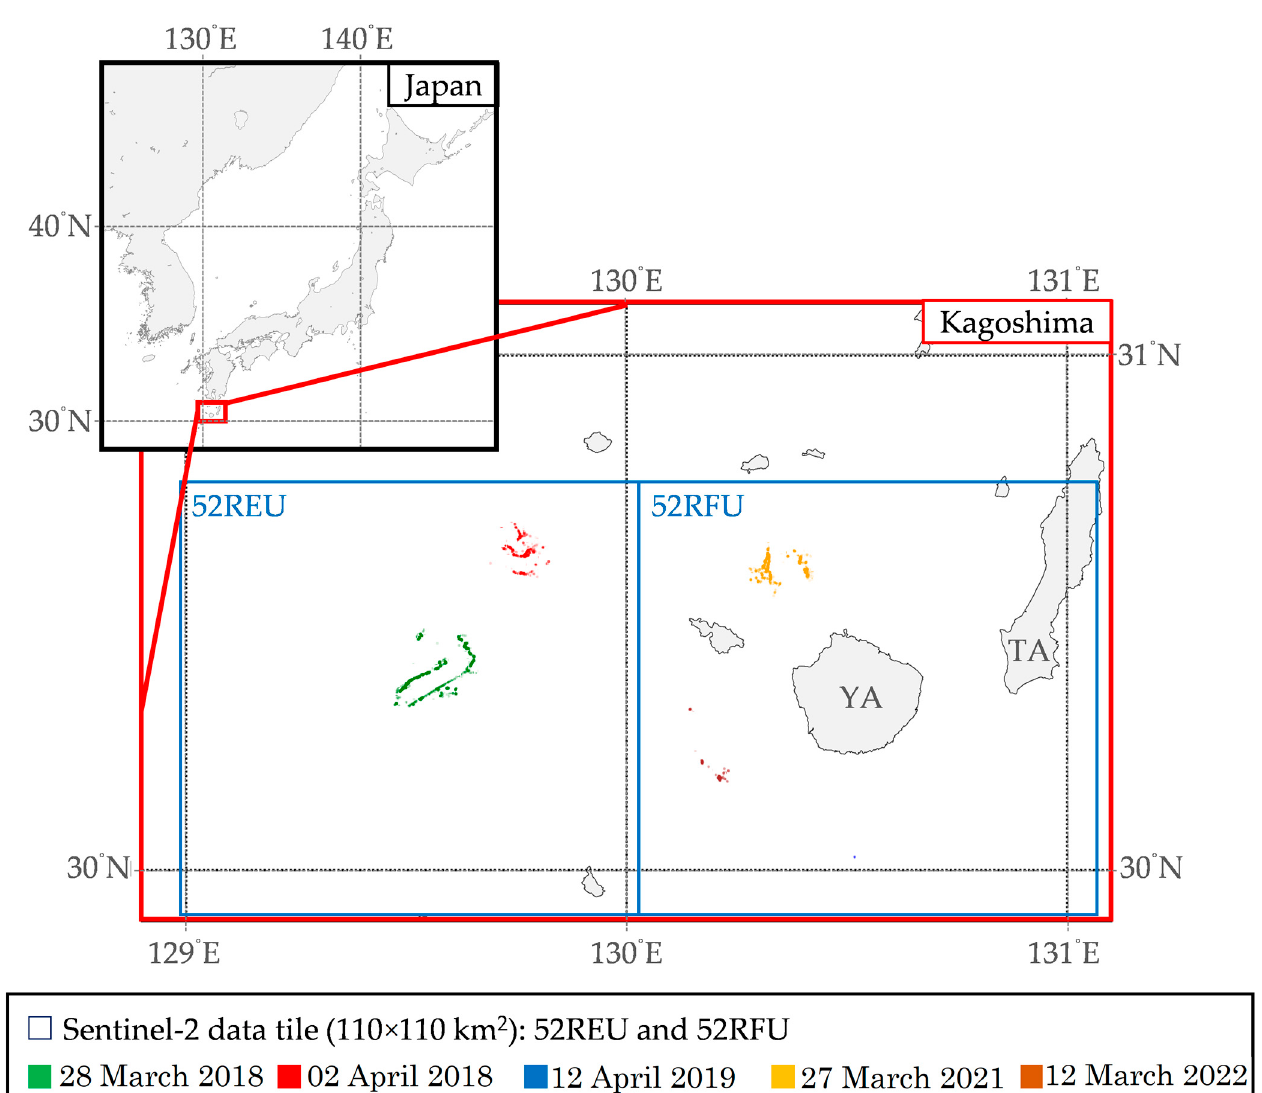
Figure 10. Distribution of fl oating macroalgae in the Kagoshima area.